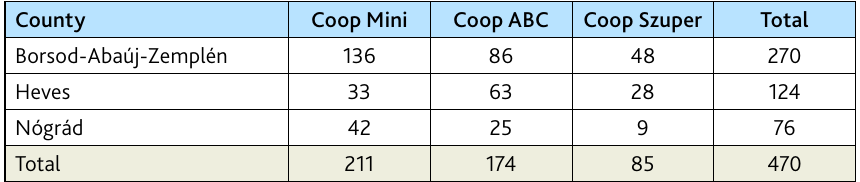
Table 3. Distribution of Coop stores by county, 2022 County